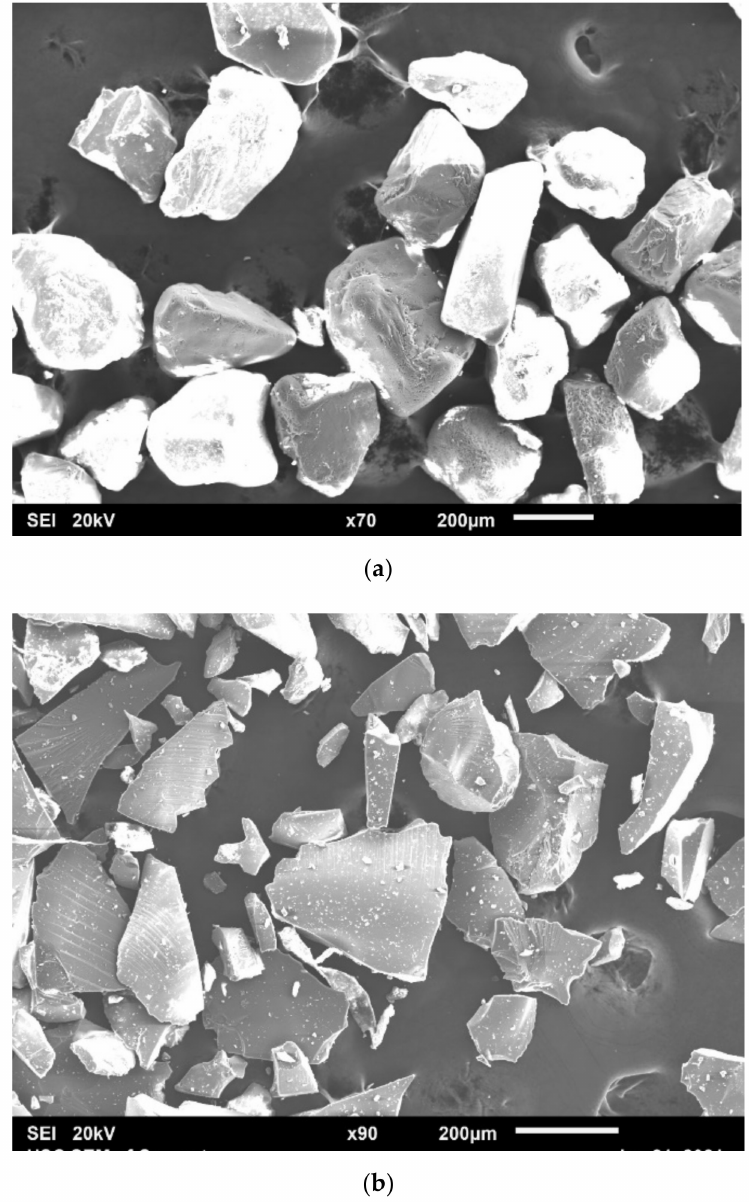
Figure 6. SEM microscopy showing morphology of fine aggregates: ( a ) Riverbed sand, ( b ) Glass